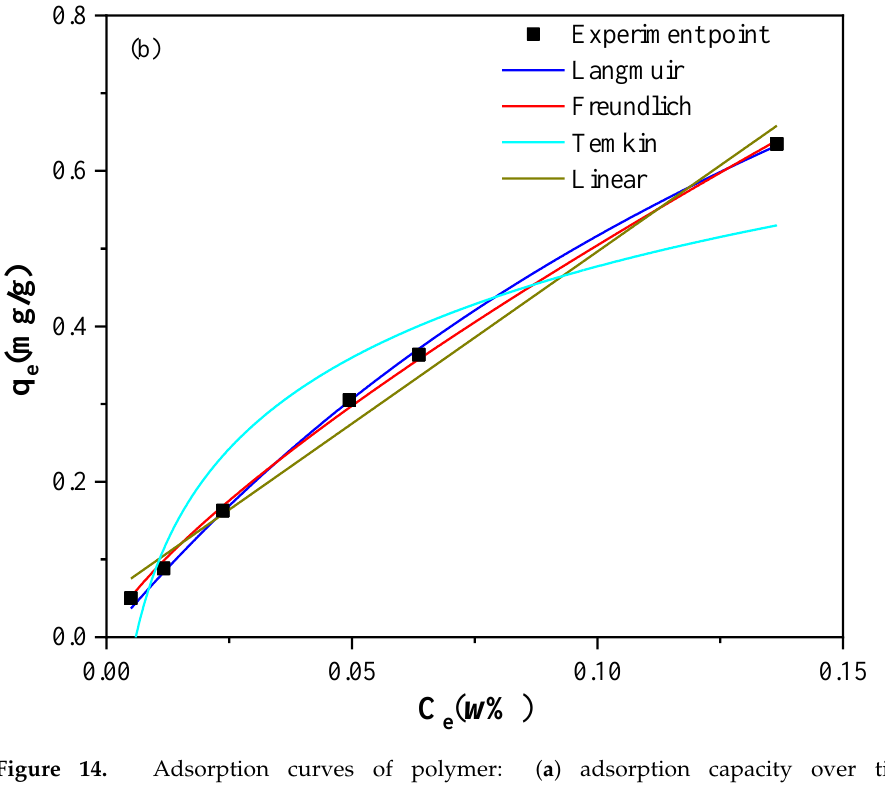
Figure 14. Adsorption curves of polymer: ( a ) adsorption capacity over time and ( b ) adsorption iso- therm.